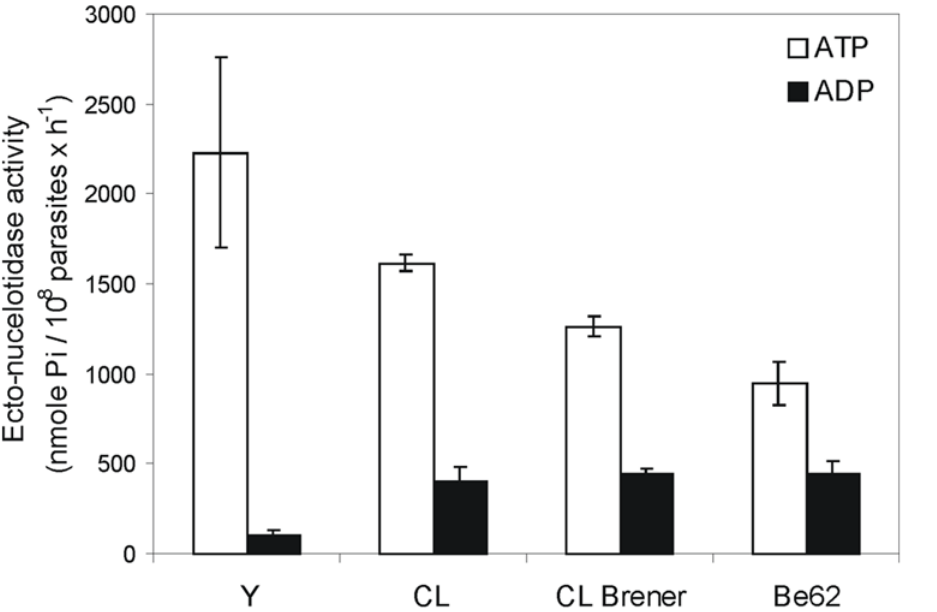
Figure 1. Ecto-nucleotidase activities of trypomastigotes from different strains/clone of T.cruzi . Trypomastigotes were obtained from the first VERO cells passage (P1). The Ecto-ATPDase activities were measured at 37 u C during 1 hour. Data are mean 6 SE of two independent experiments in triplicate.